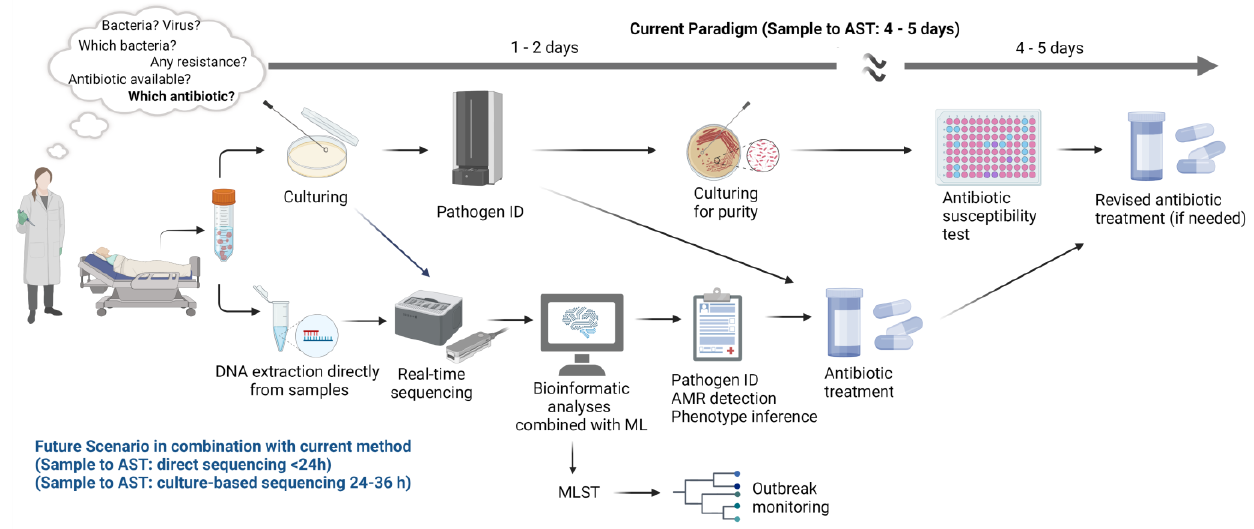
Figure 2. An overview of the current paradigm and future scenario in clinical microbiology. The current paradigm for the diagnosis in the case of infection suffers from a high turnaround time for both pathogen identification and antibiotic susceptibility testing (4–5 days). The potential future scenario with the use of whole genome sequencing has the potential to remarkably reduce the turnaround time. In the future scenario, sequencing can be implemented following direct sequencing from biological material (<24 h) or from bacterial colonies in the culture (24–36 h). Sequencing needs to be followed by proper bioinformatic analyses and ideally combined with a machine learning approach. Created with BioRender.com.